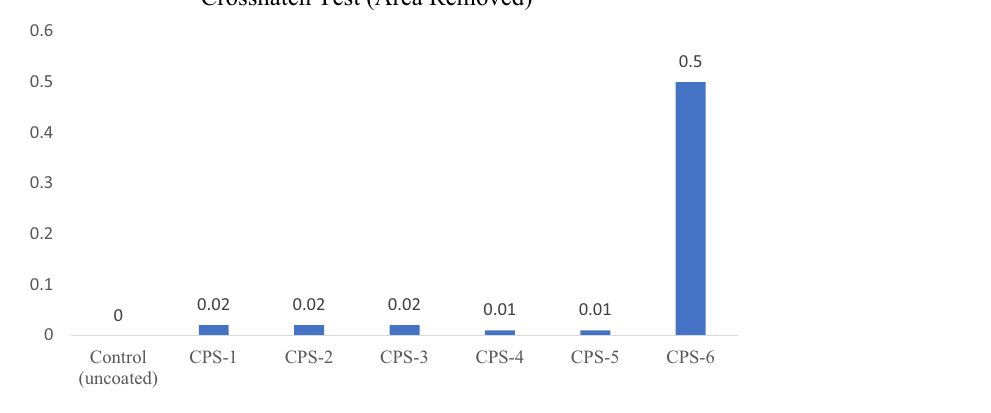
Figure 16. Adhesion of coating.